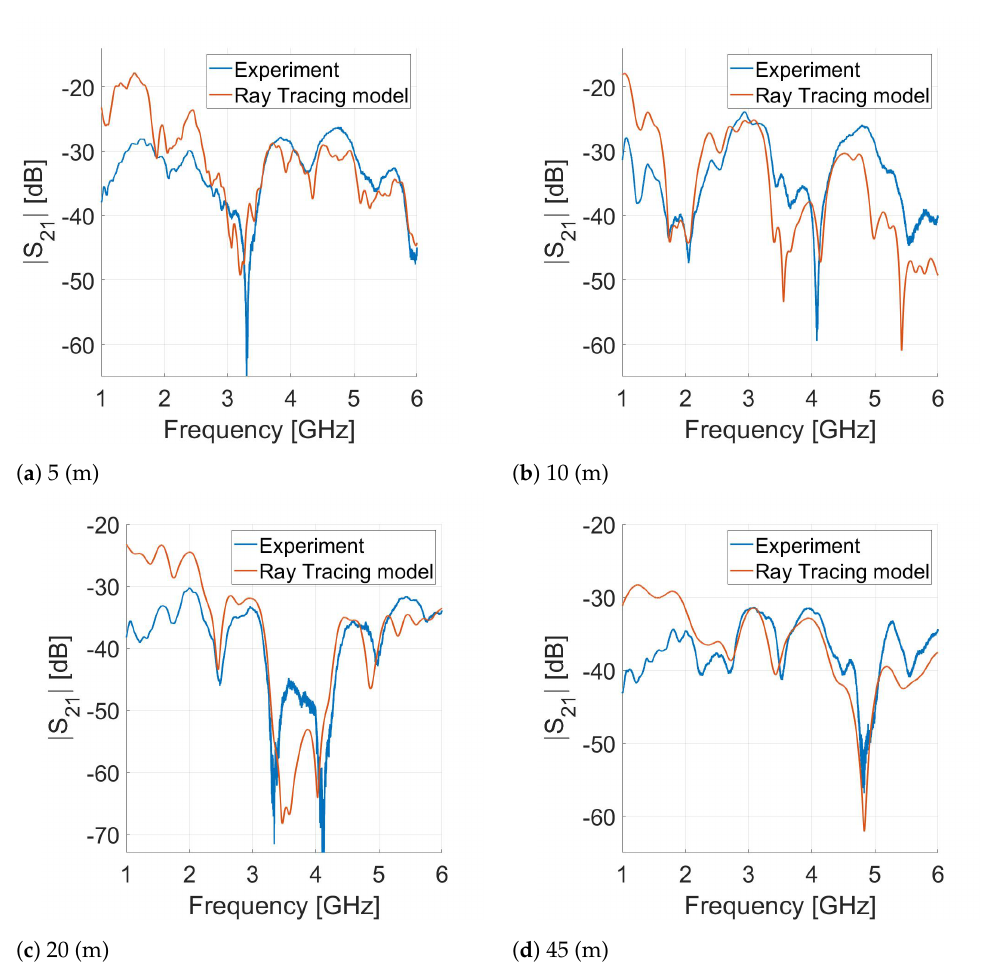
Figure 7. The frequency response of the transmission scattering parameter S 21 for various